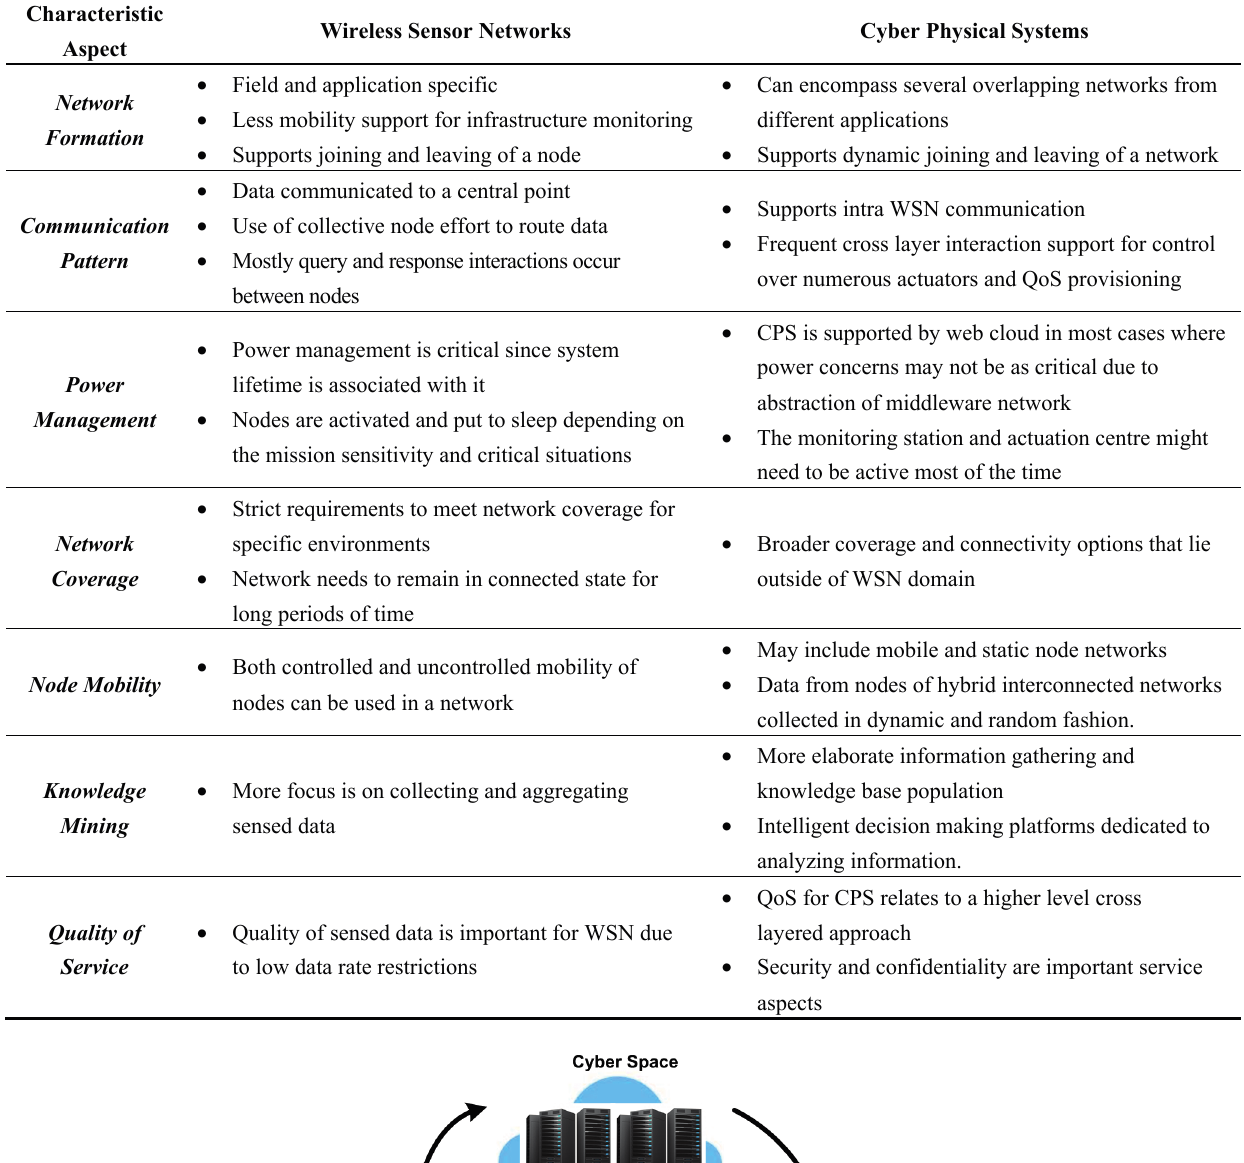
Table 2. Technical requirements for cyber physical systems and wireless sensor network architectures. Characteristic